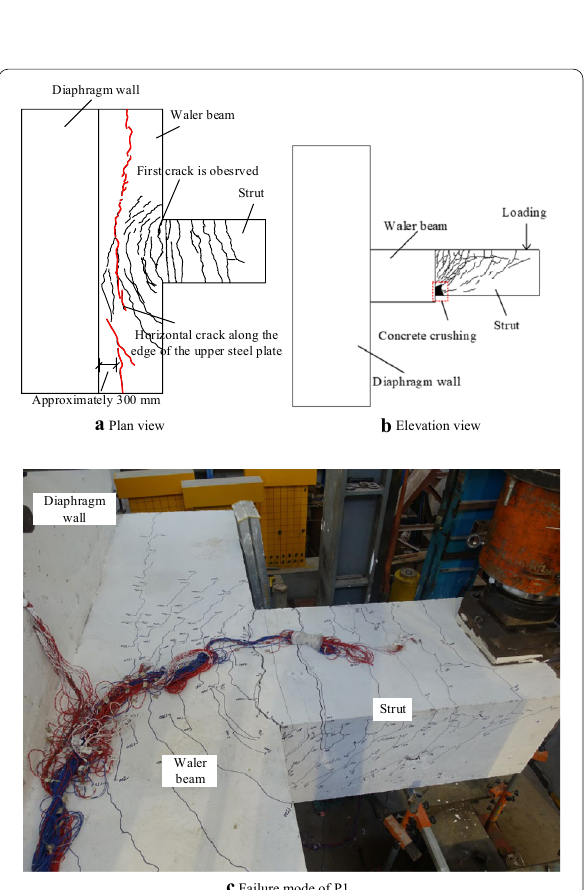
Fig. 11 Crack distribution at failure of P1.